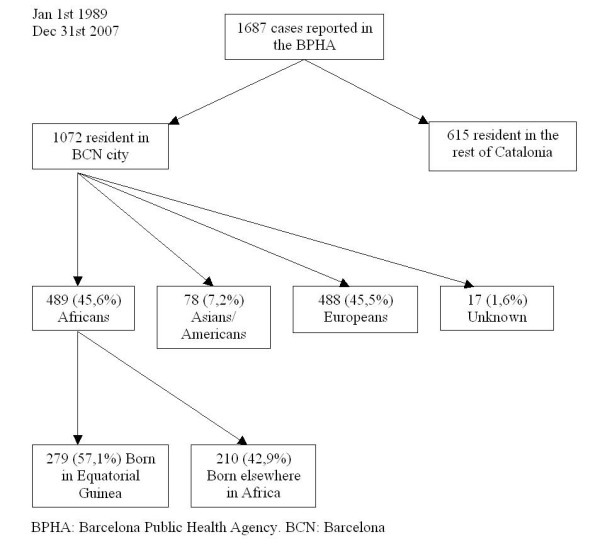
Selection of patients with imported malaria according to place of birth. Barcelona, 1989–2007.